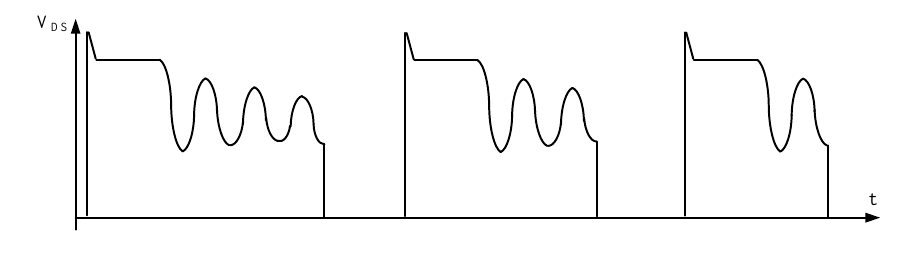
Figure 8. Valley order change.